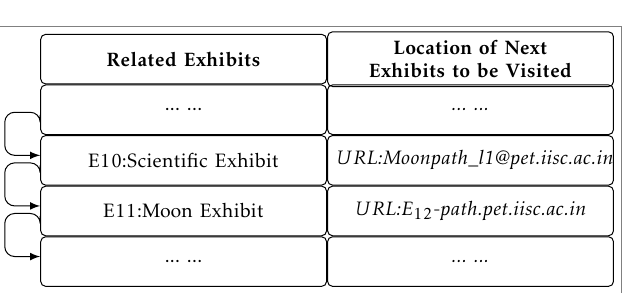
Figure 7. Locations of Next Exhibits to be Visited by School Kid Ubiquitous Visitors